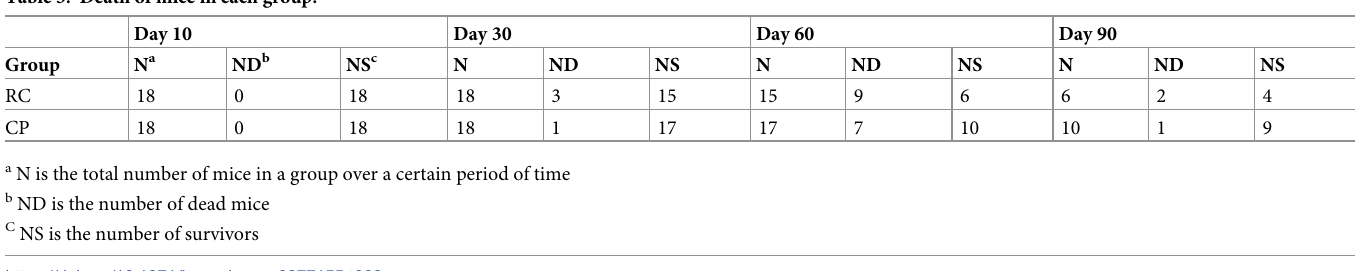
Key bacteria affected by the probiotic powder in CRC Next, we focused on determining the bacteria affected by treatment with the probiotic powder at different time points using MetStat analysis. Fig 4A and 4B show a histogram of species rela- tive abundance at the level of phylum and genus, respectively. As shown in Fig 4C–4F, at week